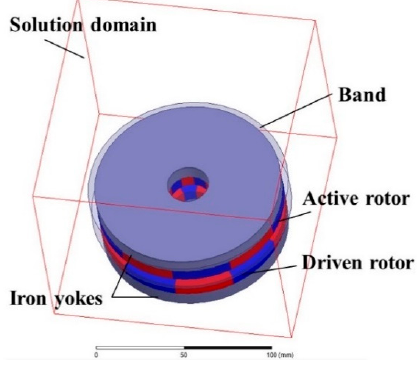
Figure 6. The simulation model of the magnetic coupling.